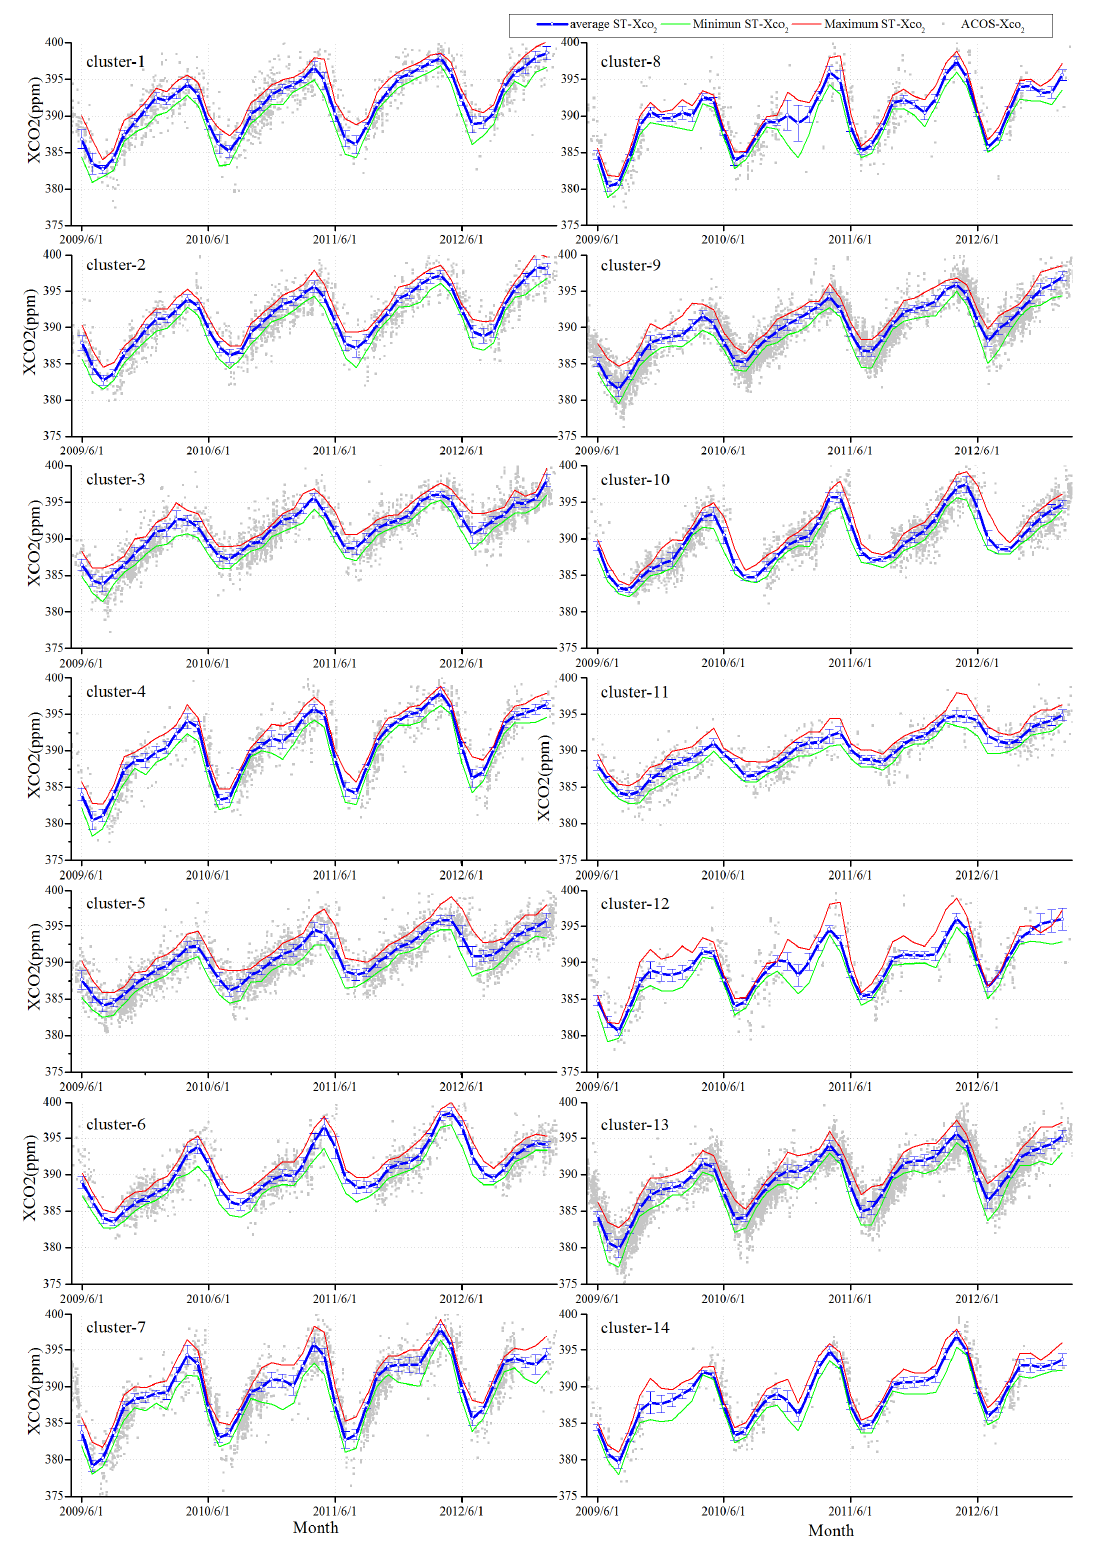
Figure 9. Variation of monthly averaged Xco in each Cluster (number of clusters k = 14). Blue, 2 values in each cluster, green, and red lines correspond to average, minimum, and maximum Xco 2 respectively, derived from the gap-filled Xco dataset. Error bars represent one standard 2 deviation of Xco , and the grey scatter points correspond to original observations from the 2 ACOS-Xco 2